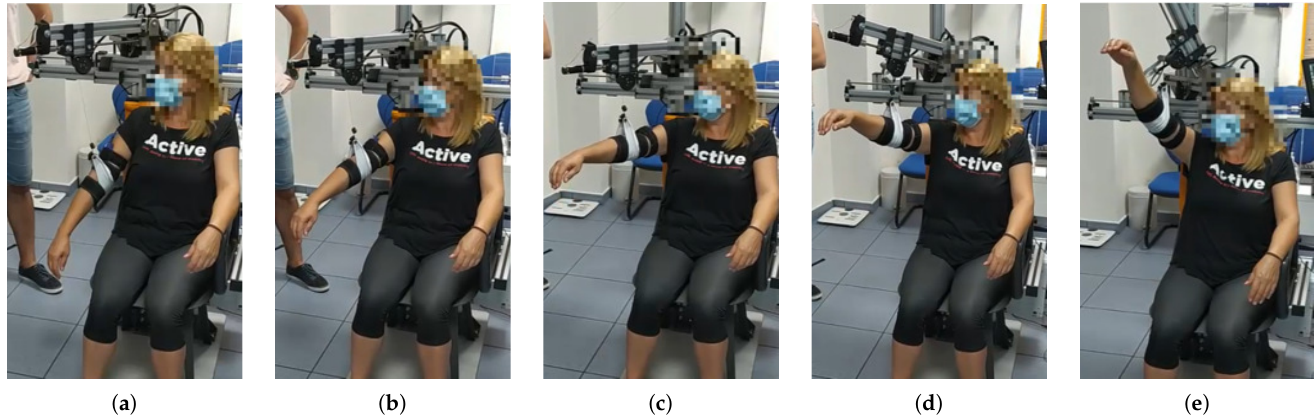
Figure 6. From ( a – e ) a series of frames corresponding to an intermediate aperture angle elevation ( θ = 30 ◦ ) are shown. The maximum elevation angle for this patient was set to φ = 145 ◦ , according to the clinicians’